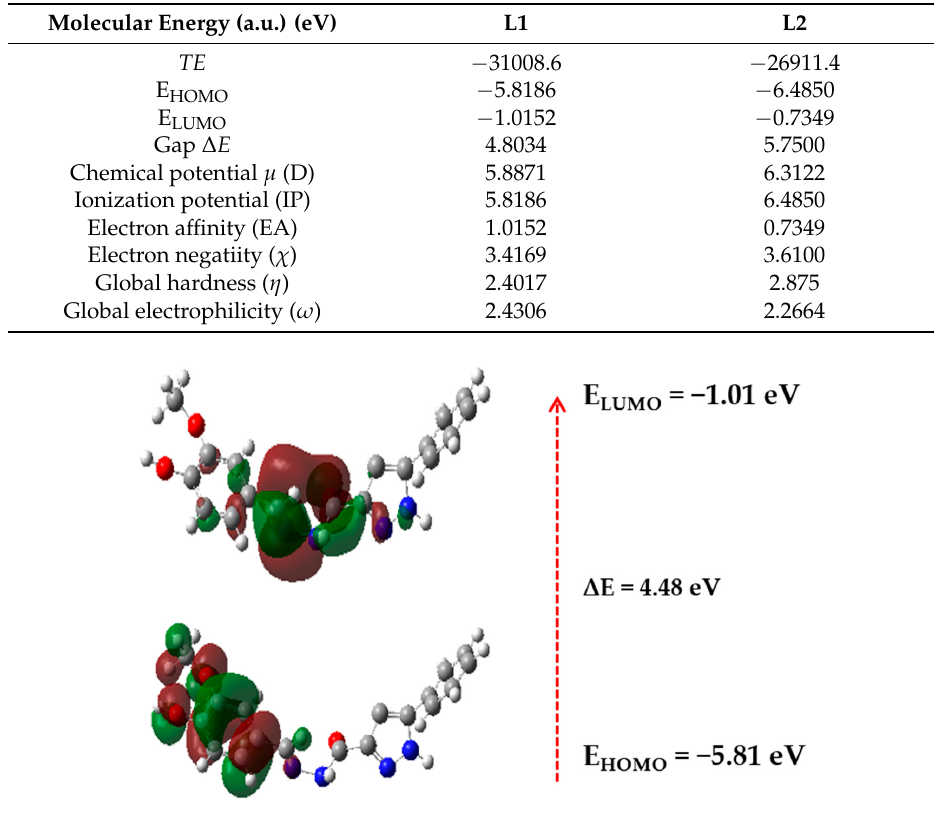
Table 3. Calculated energies of L1 and L2 .